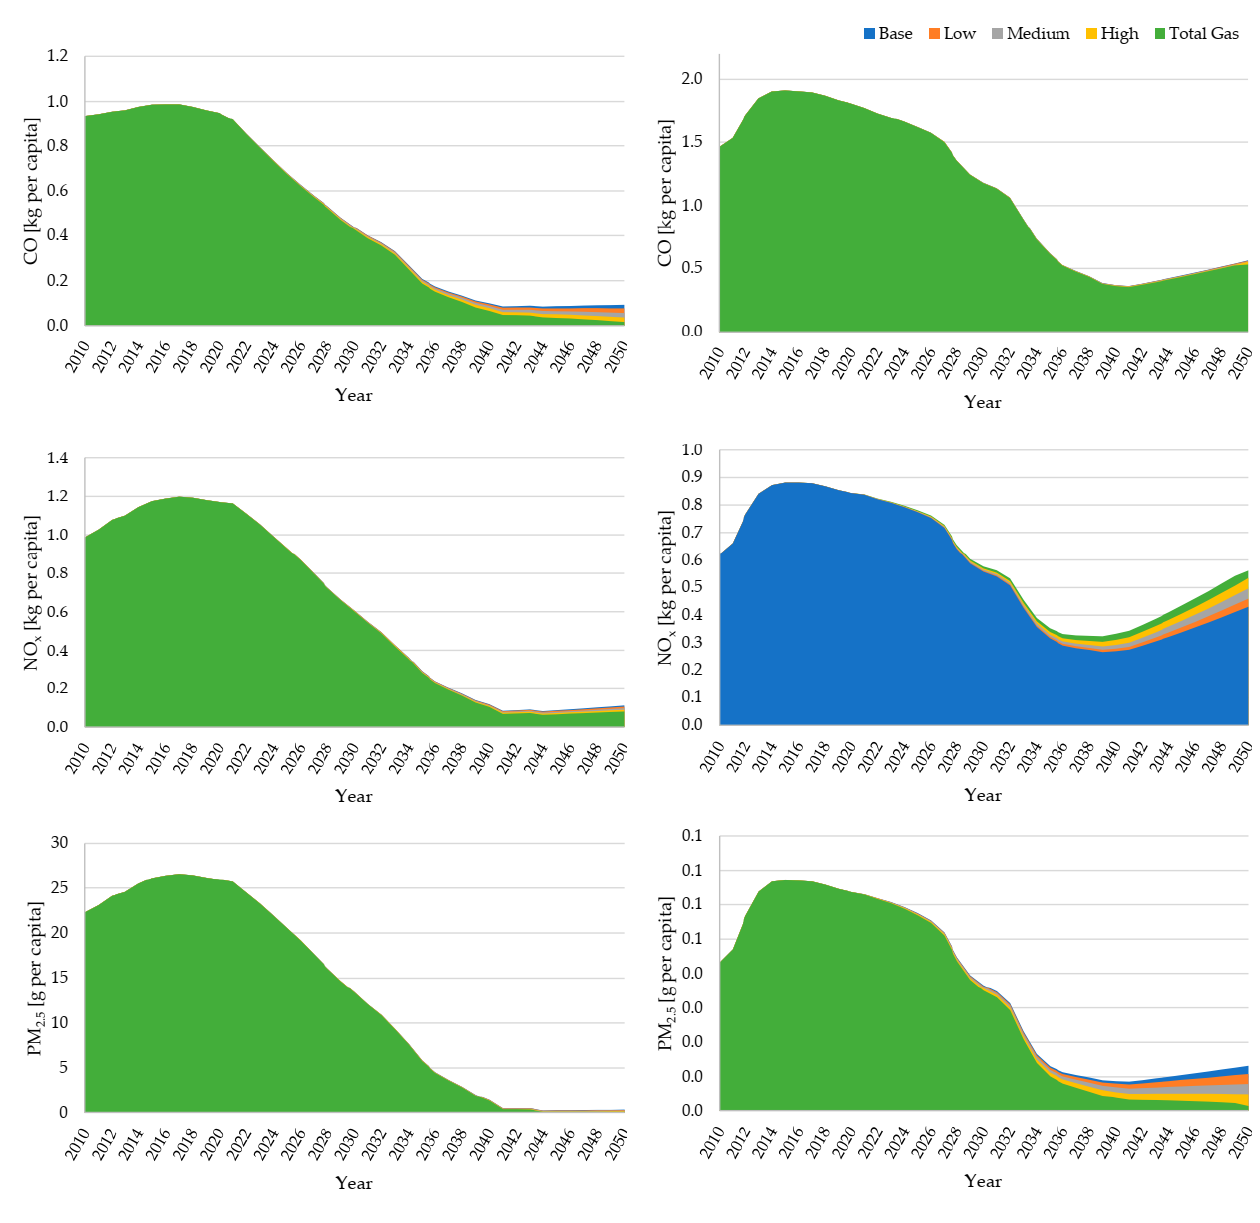
Figure 2. Pollutant emissions by